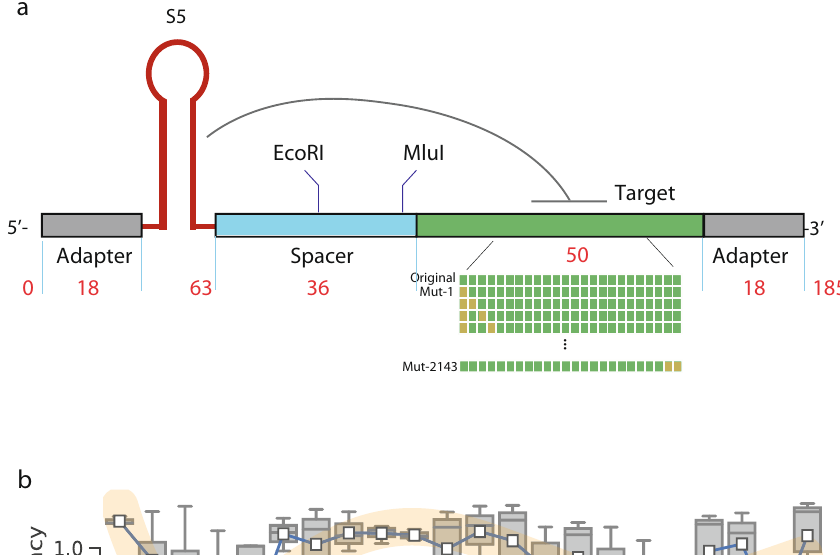
signi fi cant loss in potency (Fig. 4c; Supplementary Fig. 6). Most single mutations (56%) enhanced the Sens.AI score and were expected to increase S5 potency, which could be attributed to Ago2 dissociation dynamics 35 . In contrast, we estimated that S5